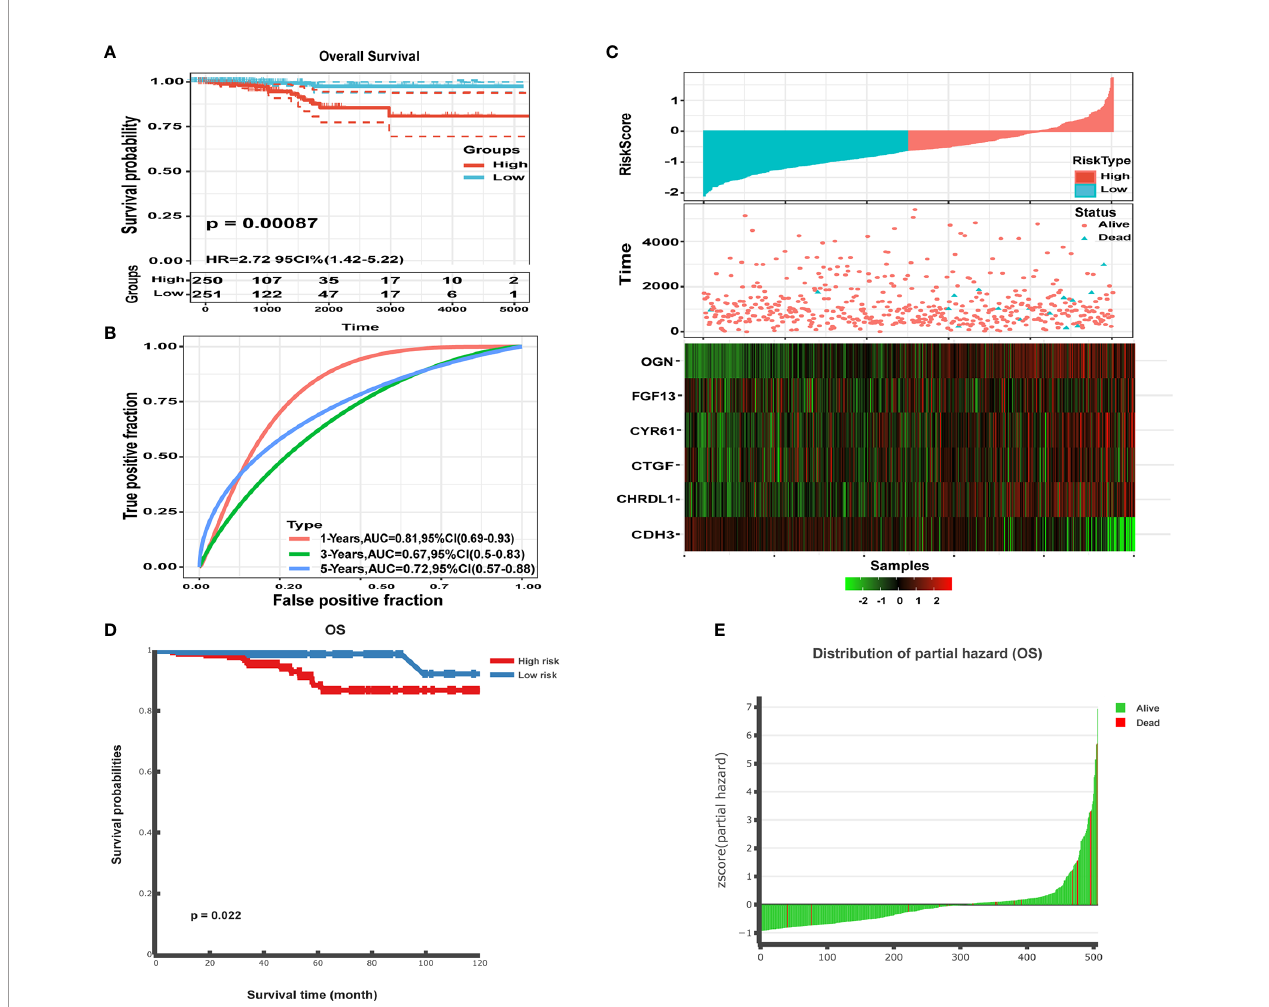
FIGURE 12 | Performance of the six gene signature model. (A) Kaplan-Meier survival curve distribution of the six gene signature from the TCGA-THCA dataset. (B) ROC curve and AUC for the six gene signature classi fi cation. (C) TCGA-THCA set focused on risk score, survival time, survival status, and expression of the six gene signature. (D) Kaplan-Meier survival analysis for the patients in the THCA dataset. Patients were divided into low risk and high risk groups using the median cutoff value of the partial hazard. P-values were calculated using the log-rank test. (E) Z-score distribution of the prognostic classi fi er and patient survival